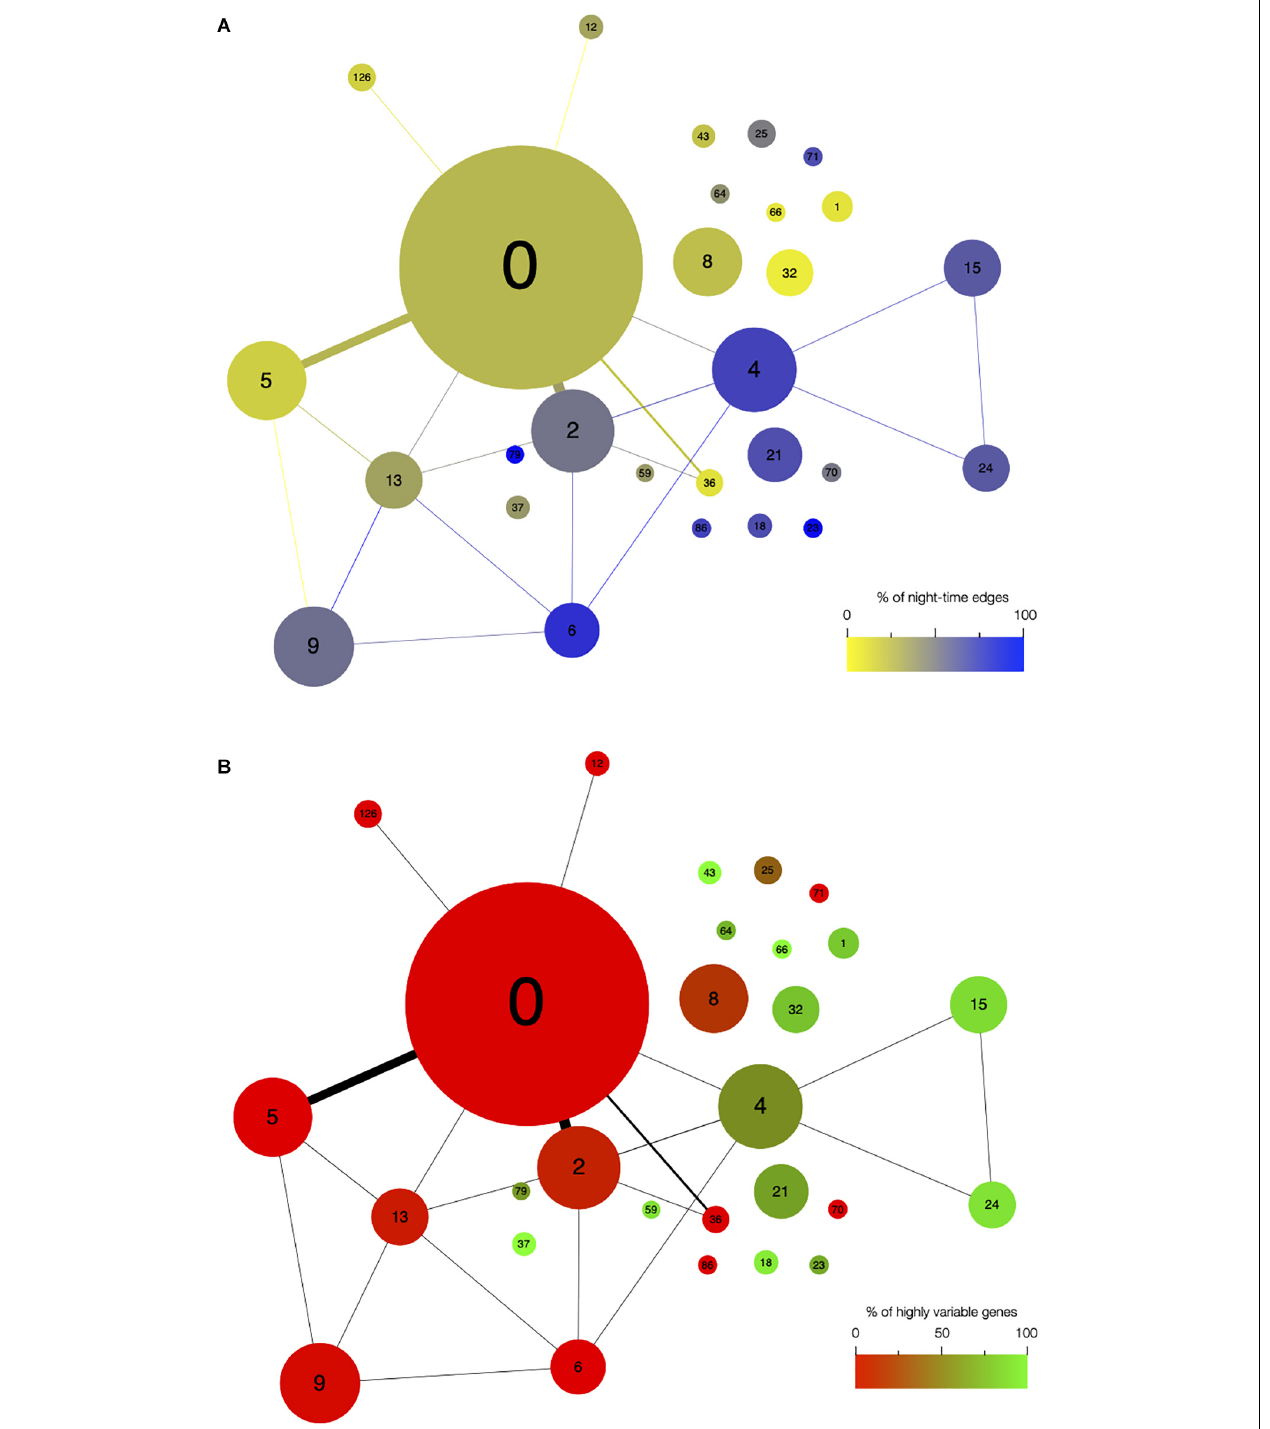
FIGURE 3 | Network architecture is mainly influenced by the time of day when edges are detected and by the presence of highly variable genes in modules. Organization of modules in the network, with the size of circles representing the module size (i.e., number of edges). Number of edges connecting the modules is represented by the thickness of the lines between modules. The number in each module corresponds to the module number. (A) Modules are color coded based on the percentage of edges that are detected during the night in each module. Blue modules are composed of a majority of nighttime edges, while yellow modules are mainly composed of daytime edges. (B) Modules are color coded based on the percentage of highly variable genes (HVGs) in the modules. Green modules are composed of a majority of HVGs while red modules have a low percentage of HVGs.